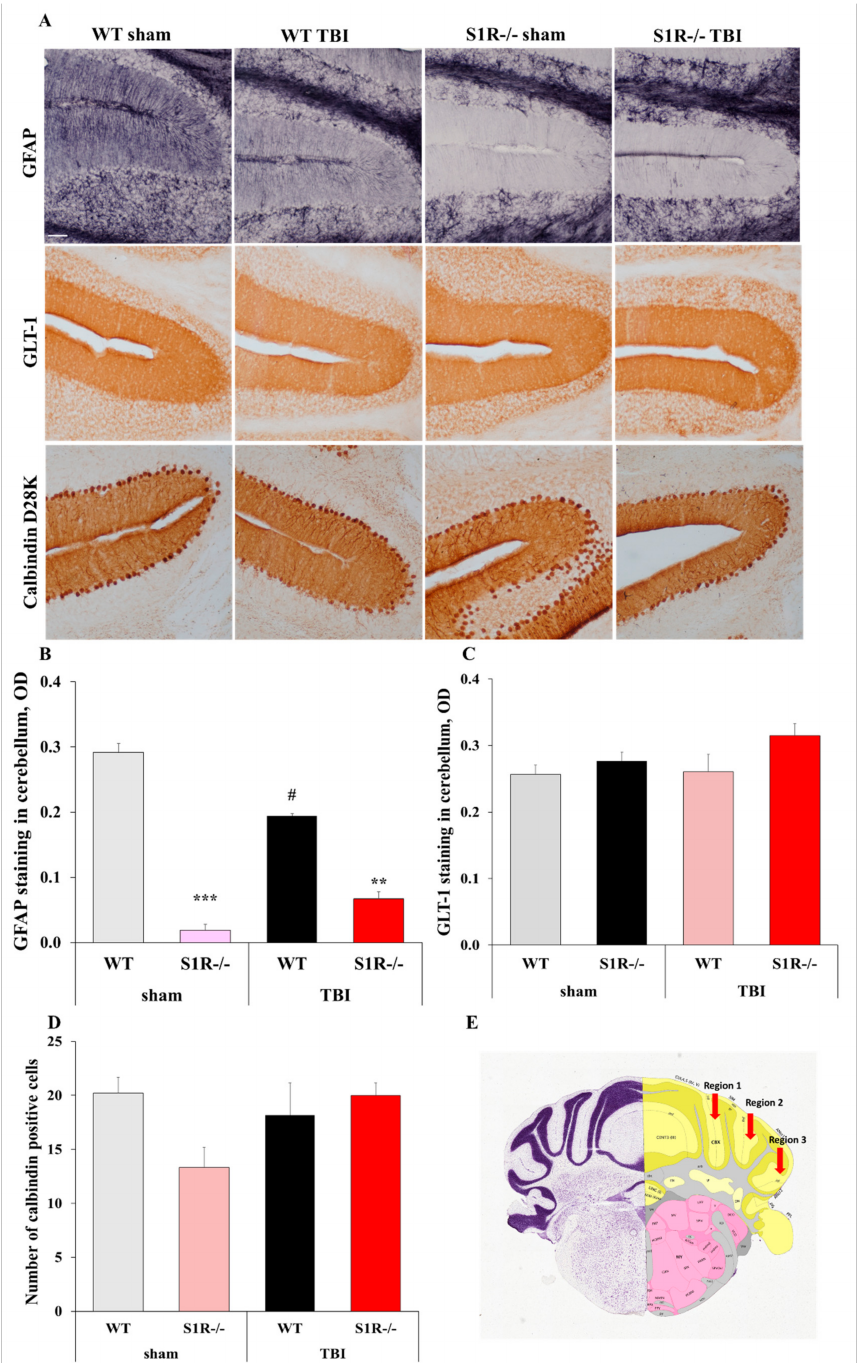
Figure 3. Staining of astrocytes (GFAP, Glt-1) and Purkinje cells (Calbindin D28K) in WT and S1R-/- mouse cerebellum slices at 12 months postinjury. ( A ) Representative images of GFAP, Glt-1, and Calbindin D28K staining in the grey matter of the cerebellum (total magnification = 100 × , scale bar = 50 µ m). OD of the GFAP ( B ), Glt-1 ( C ) staining intensity in the molecular layer of the cerebellum between the WT and S1R-/- experimental groups. ( D ) Total cell counts of Purkinje cells in the molecular layer of the cerebellum between WT and S1R-/- experimental groups. ( E ) Anatomical positions of the analyzed regions in the cerebellum (red arrows). All values are presented as the means ± SEM. p values for differences between groups were calculated using the Mann–Whitney U-test, ( n = 5): ** p < 0.01, *** p < 0.001 WT vs. S1R-/-, # p < 0.05 WT sham vs. WT